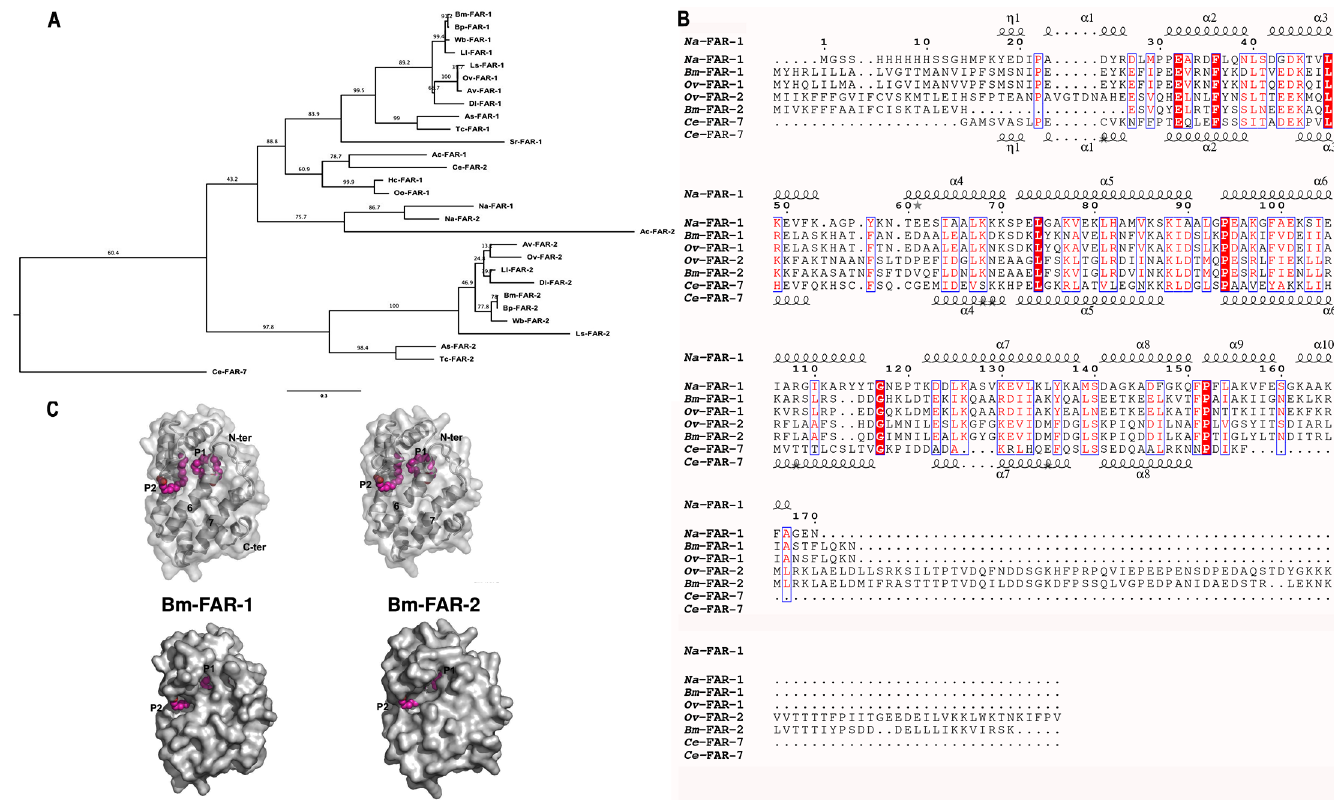
Fig 1. Sequence and structural analysis of Bm- FAR-1 and Bm- FAR-2. ( A) Phylogenetic tree of Bm -FAR-1 and Bm -FAR-2 and their homologues in other nematodes, with bootstrap values ( B) Structure based sequence comparison of Bm- FAR-1 and Bm- FAR-2, as well as Ov -FAR-1 and Ov -FAR-2, with Na -FAR-1 and Ce -FAR-7. The sequences are aligned with Clustal Omega and the secondary structural features are illustrated with the coordinates of Na -FAR-1 and Ce -FAR-7 using ESPript [52]. The different secondary structure elements shown are alpha helices ( α ), 3 10 -helices ( η ), beta strands (arrows), and beta turns (TT). Identical residues are shown in solid red, and conserved residues are in red. Black box indicates the conserved casein kinase II phosphorylation site. The N-glycosylation site at 53-NFS for Bm -FAR-2 and Ov - FAR-2 is underlined. The amino acid sequence identity of orthologues between B . malayi and O . volvulus is shown at the end of sequence alignment. ( C) Predicted tertiary structures of Bm -FAR-1 and Bm -FAR-2 showing retinol-binding pocket (P1) and fatty acid binding pocket (P2). The palmitate molecules from the Na -FAR-1 structure are modeled into the pockets as magenta spheres. Top panel shows transparent surfaces of the models and the retinol-binding pocket P1 is formed by helices α 2 and α 6, which are well conserved. The fatty acid binding cavity P2 is formed by helices α 4 and α 5, which are poorly conserved. The bottom panel of the solid surface plot shows that the retinol-binding pockets (P1) are similarly located and oriented in both models, whereas the fatty acid binding pockets (P2) are smaller and less accessible in Bm-